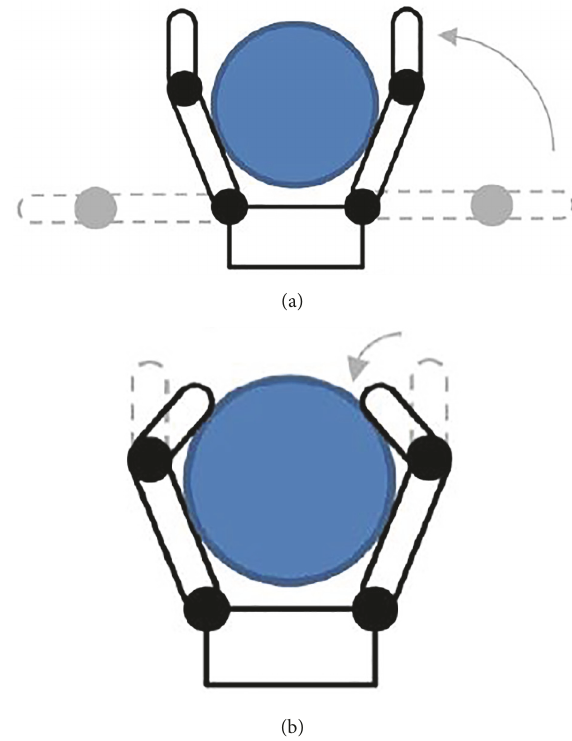
Figure 1: Grasping model of robot